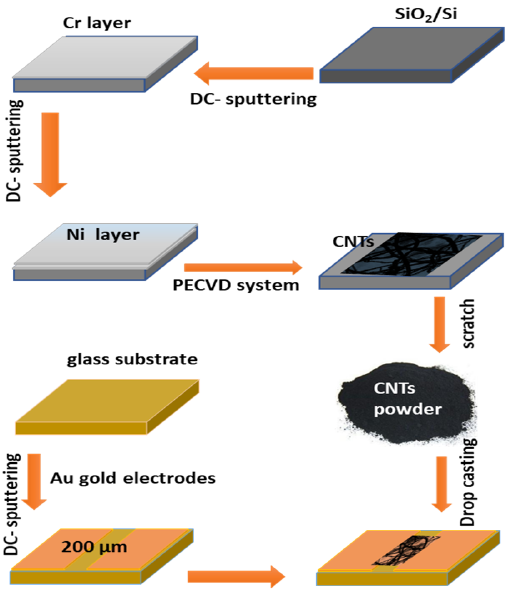
Figure 1. The steps for CNTs preparation and device fabrication.